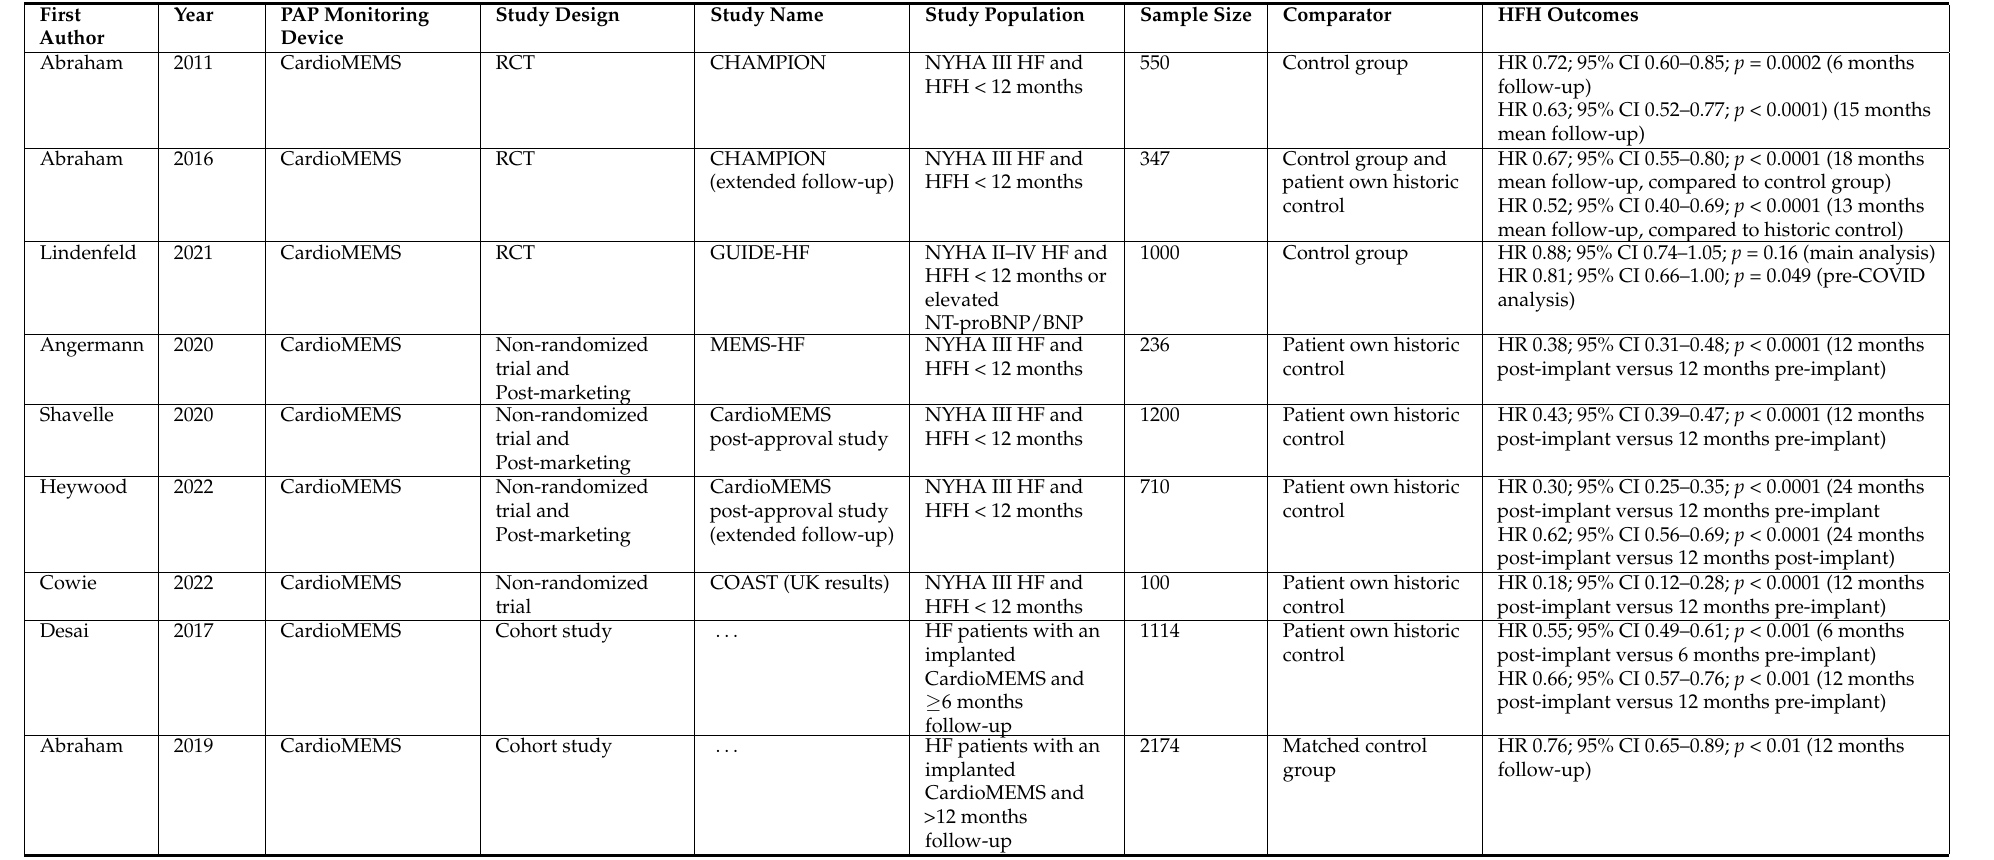
Table 1. Overview of the main studies assessing pulmonary artery pressure monitoring for heart